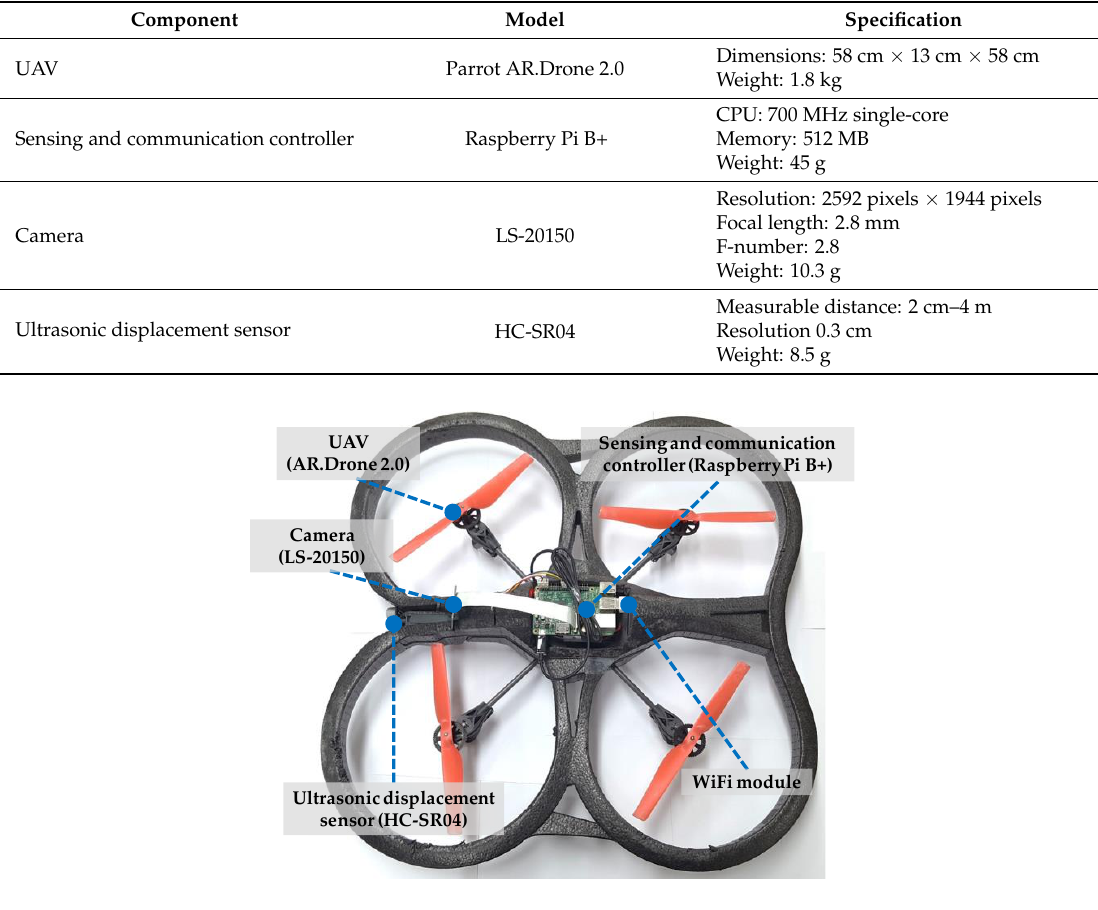
Figure 4. UAV-based system for crack information acquisition.